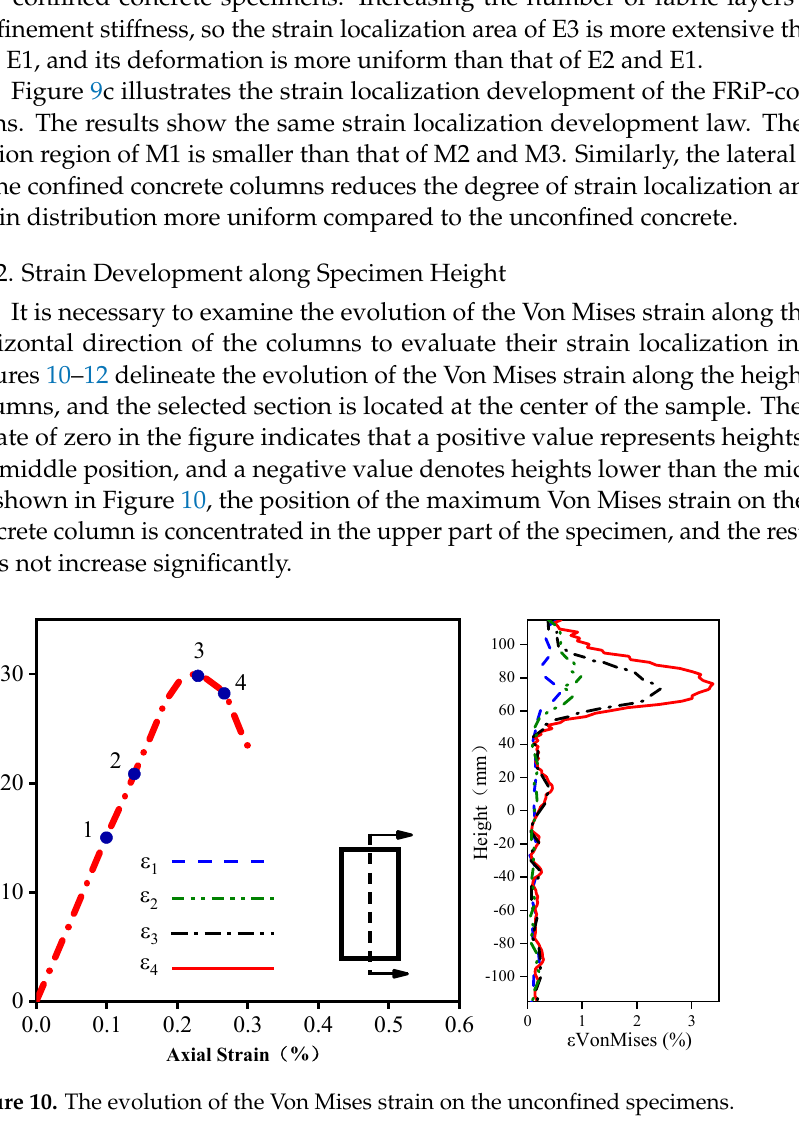
( b ) ( c ) Figure 11. Comparing the Von Mises strain development of ( a ) E1, ( b ) E2, and ( c ) E3.